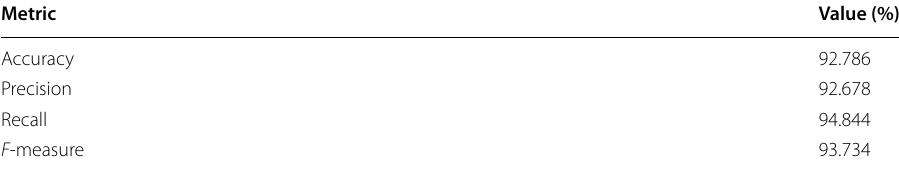
Table 4 Performance of NADLA Model